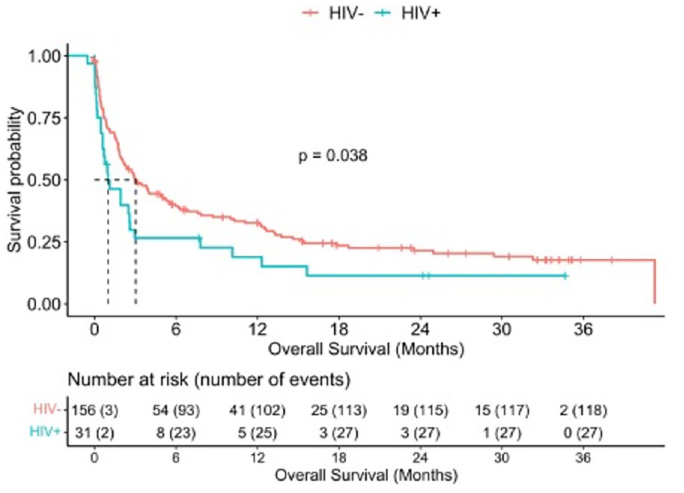
Fig 1. Overall survival by HIV